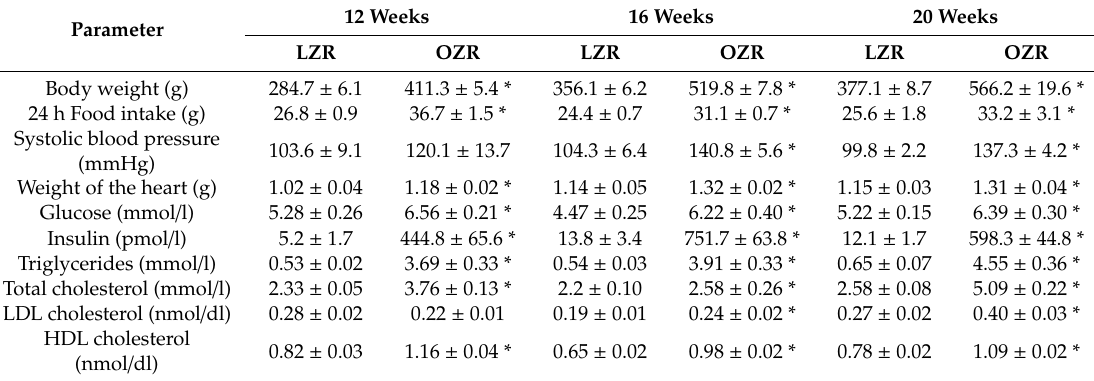
Table 1. Physiological and blood parameters of obese Zucker rats (OZR) and lean Zucker rats (LZR) at 12, 16, and 20 weeks of age.